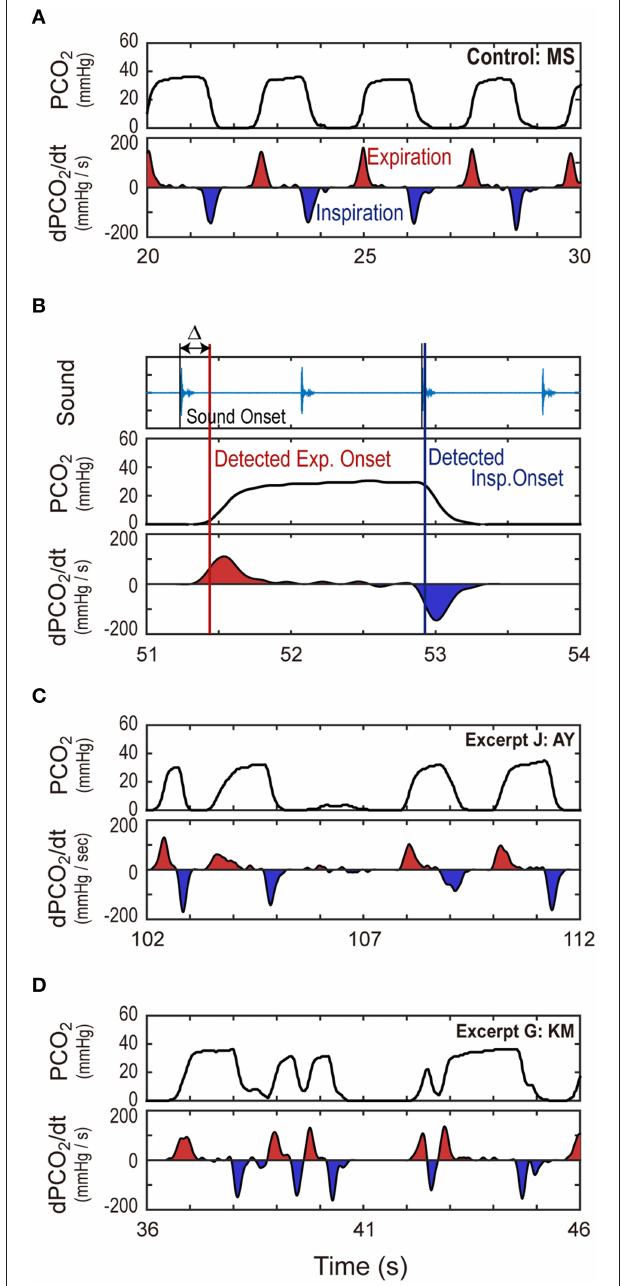
FIGURE 1 | Typical behavior of CO 2 partial pressure. (A) A temporal profile of the CO 2 partial pressure (PCO 2 ) of a participant is shown, together with its temporal derivatives. (B) A PCO 2 pattern is shown when an experimenter inspired and expired for every two beats of metronome sounds whose signal is depicted in the top panel. Vertical red and blue lines were the timing of the expiration and inspiration detected by the signal processing program. Although little difference was found between the detected inspiration onset and the sound onset, there was non-negligible time difference ( 1 ∼ 200ms) between the detected expiration onset and the sound onset. (C) An example of temporally irregular PCO 2 patterns is shown. In this example, the amplitude of PCO 2 temporal derivative greatly varied among individual breaths. (D) Another example of irregular PCO 2 patterns is shown. In this example, PCO 2 started to increase before it reached the zero